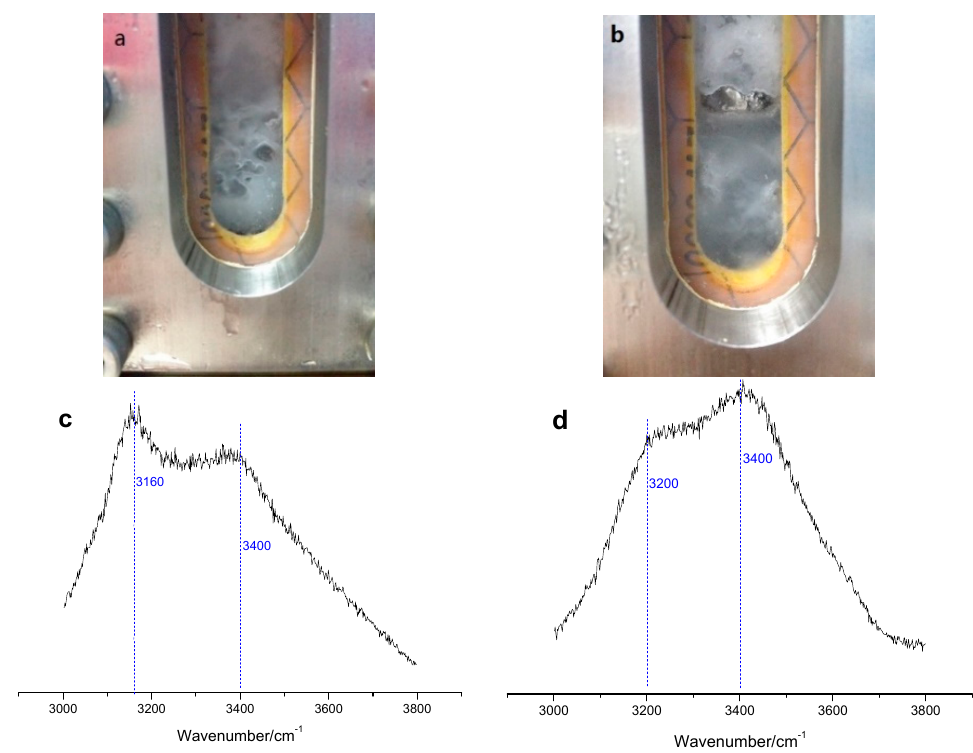
Figure 5. The picture of vessel at the first ( a ) and sixth ( b ) day of replacement reaction for experiment 1, and the Raman peak change between 3100 and 3500 cm − 1 during experiment 2 ( c , d ). It can be seen that the Raman peak shows sharp appearance at about 3160 cm -1 and short appearance at about 3400 cm − 1 which are attributed to O-H symmetric stretching vibration of H 2 O molecules in sI hydrate, then along with the replacement progress the peak appearance changes to